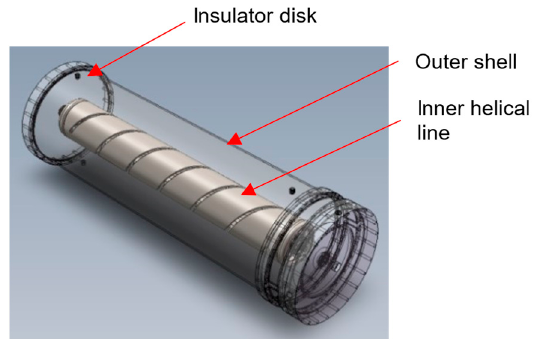
Figure 4. The geometry of the helical forming line.